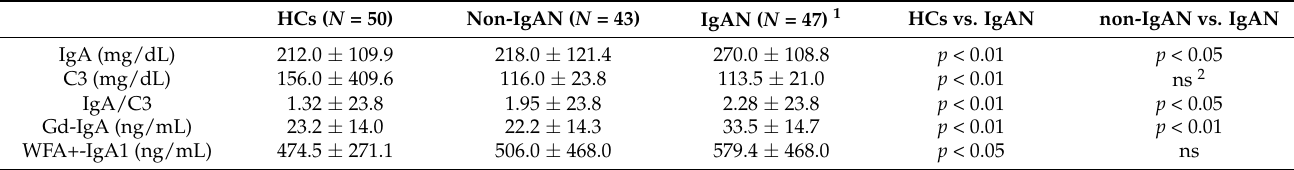
Table 1. Clinical features of each marker in HS, non-IgAN, and IgAN patients.